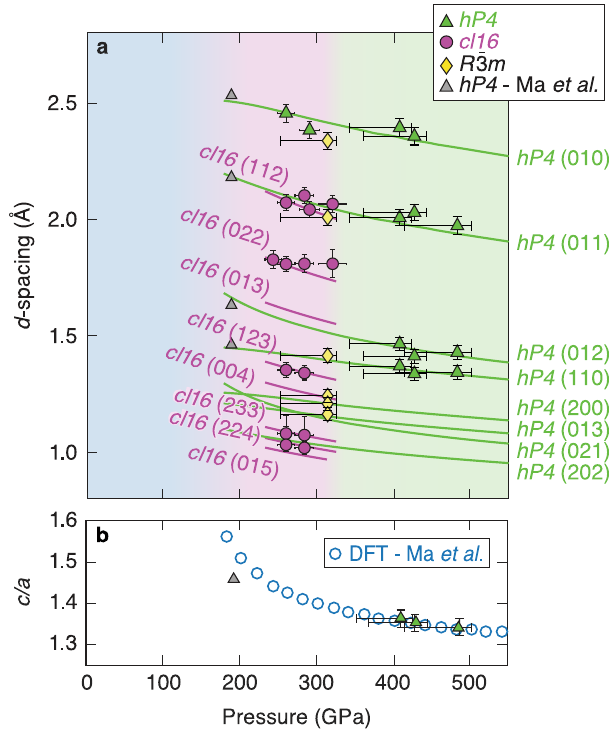
Fig. 4 Data compared to theoretical predictions. a A comparison of the measured d -spacing versus pressure from this work, 0 K DFT equation of state assuming the hP4 structure 3 (green curves), a Vinet fi t to the cI16 data (purple curves) 34 , and static compression experiments 3 . Error bars de fi ned in Supplementary Discussion. b Changes in the c/a axial ratio in the hP4 phase are in excellent agreement with 0 K DFT predictions 3